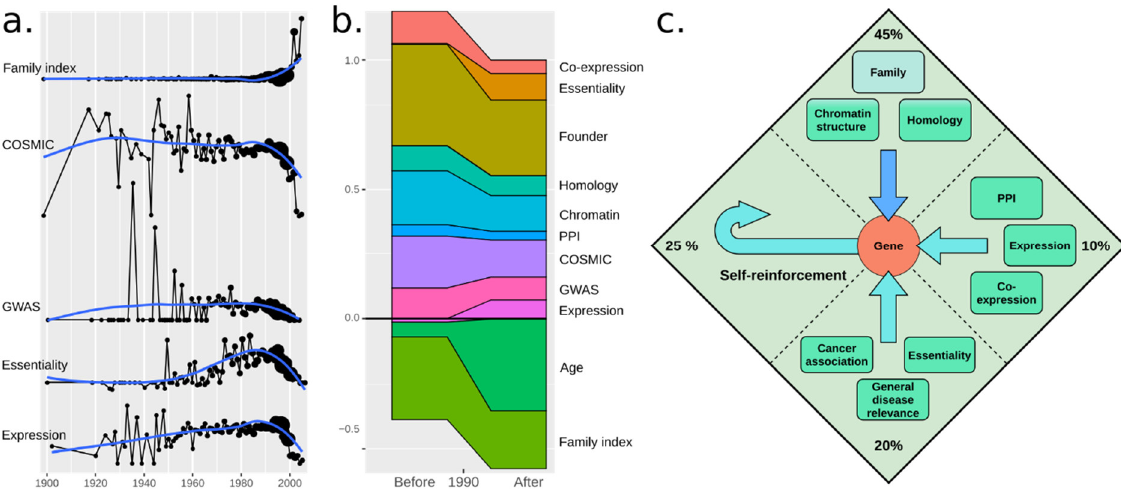
Figure 3. ( a ) Time series plot for several features where each point represents the year of first citation of a gene, from 1900 to 2010. Reinforcement sources for genes tend to vary over time, hinting at the existence of underlying social features for gene popularity (not included in this study), highly dependent on time. ( b ) Time series plot for all model-relevant feature weights for genes discovered between 1970–1990 and 1991–2010. Certain features like expression and essentially seem to be especially relevant as popularity determinators for genes discovered after 1990. ( c ) A summary of the proposed model of gene popularity reinforcers showing the total percentage of different sources of reinforcement.